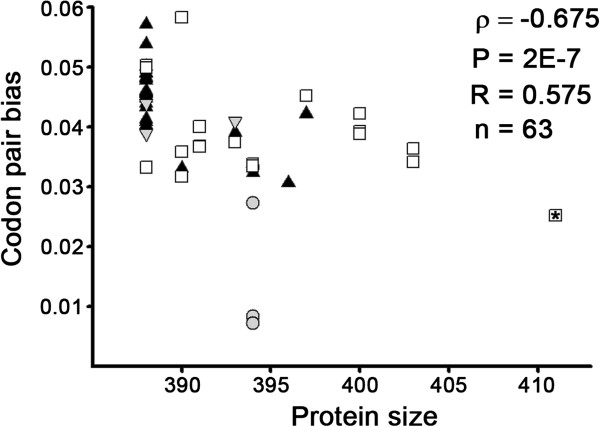
Relationship between CPB and HE size. The figure shows the CPB values of 63 proteins with complete sequences in the encoding region of the HE gene. The CPB values are shown for HE genes in the Norwegian virus (white squares), North American virus (gray circles), the Chilean virus (black triangles) and the British virus (inverted gray triangles). The square with a star indicates the HE gene of the HPR0 genotype.